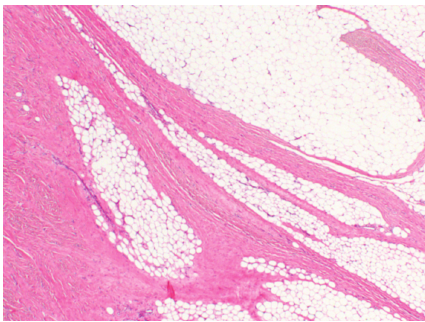
Figure 3: Low magnification view of myolipoma. The tumour is characterised by lobules of adult-type (mature) adipose tissue intimately admixed with sheets and septa of smooth muscle. Both components lack cellular atypia (H&E stain; 2 ×